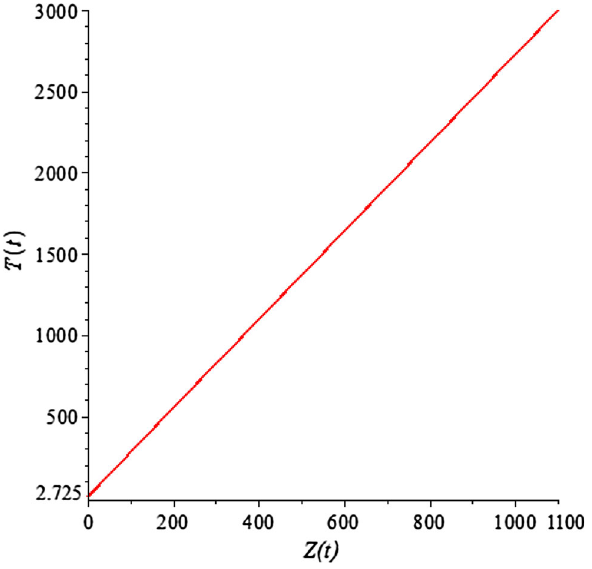
Fig. 6 The CMBR temperature T versus redshift z plot shows presently T 0 = 2 . 725